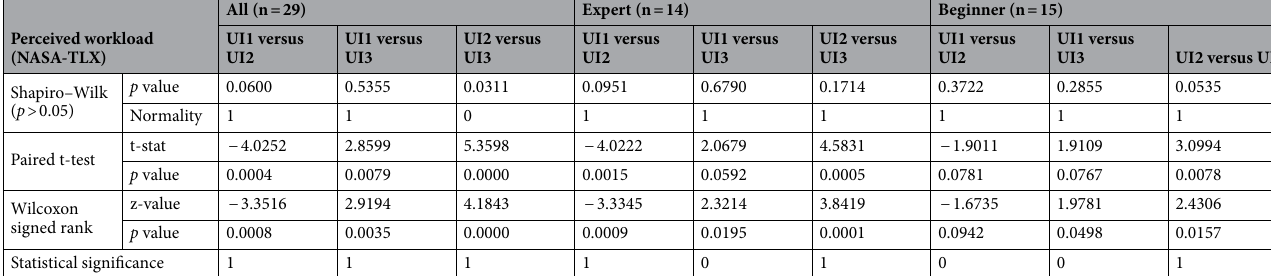
Table 3. Statistical analyses for perceived workload